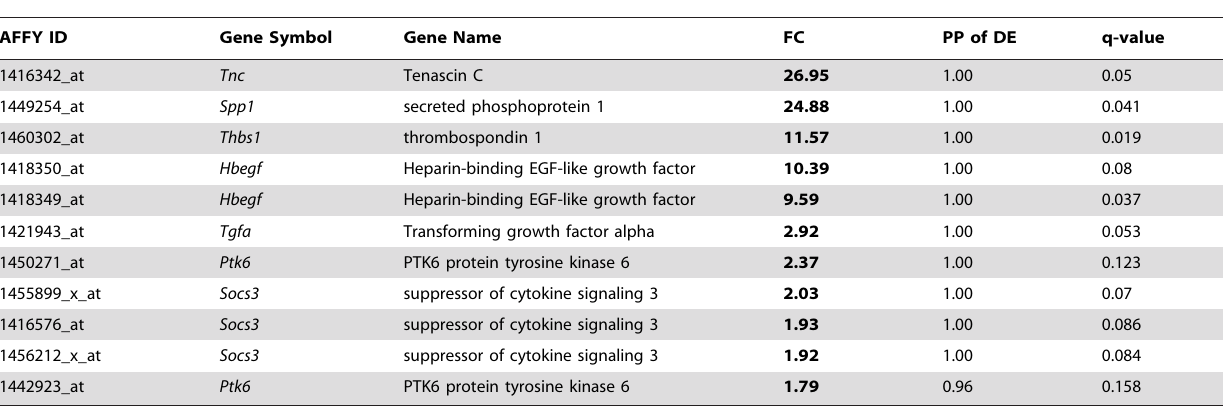
Table 7. Increased in wounded and inflammed skin, psoriasis.